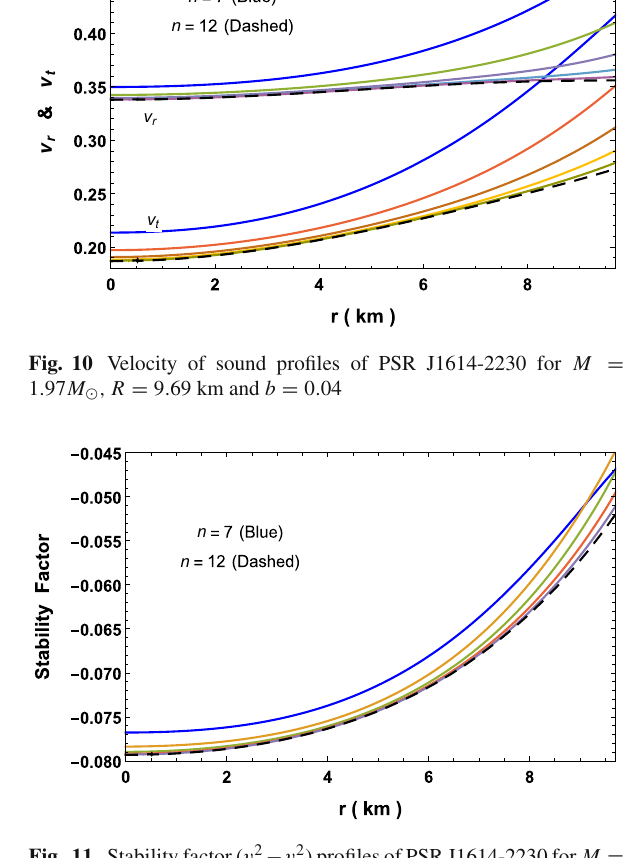
Fig. 11 Stability factor ( v 2 t − v 2 r ) profiles of PSR J1614-2230 for M = 1 . 97 M (cid:6) , R = 9 . 69 km and b = 0 . 04